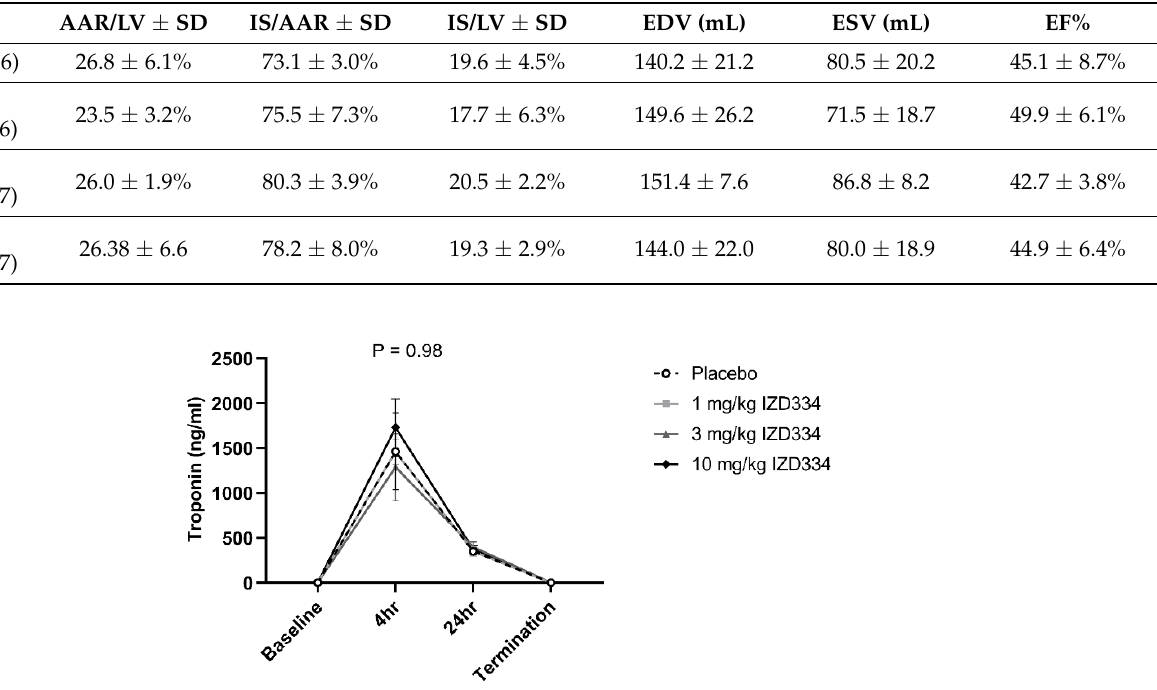
ventricle; IS, infarct size. EDV, end-diastolic volume; ESV, end-systolic volume; EF, ejection fraction.